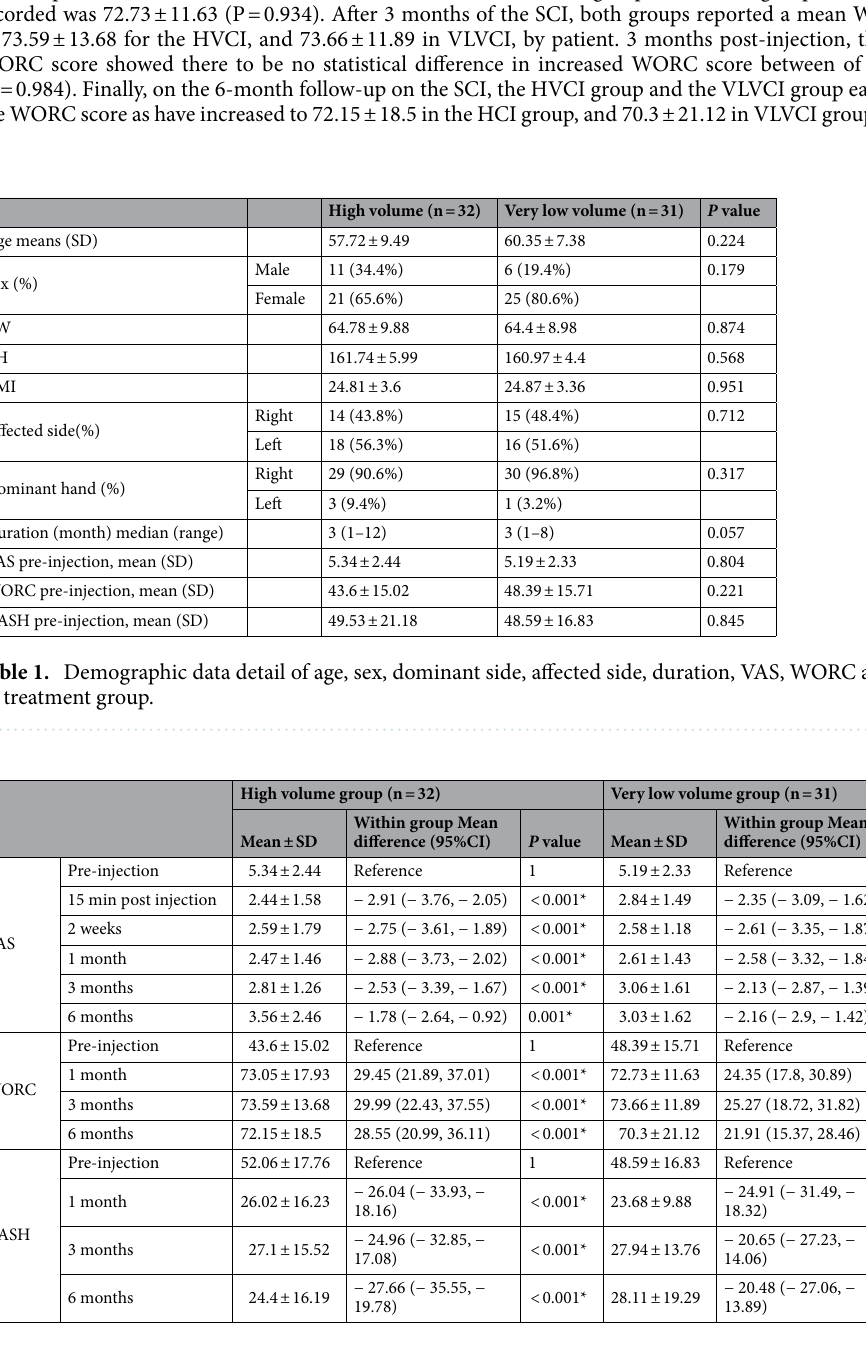
Table 2. Result of Mean of VAS, WORC and DASH within group at difference time compared after baseline, 2 weeks and 1-, 3- and 6-months follow-up. * The data was statistically significant ( P -value